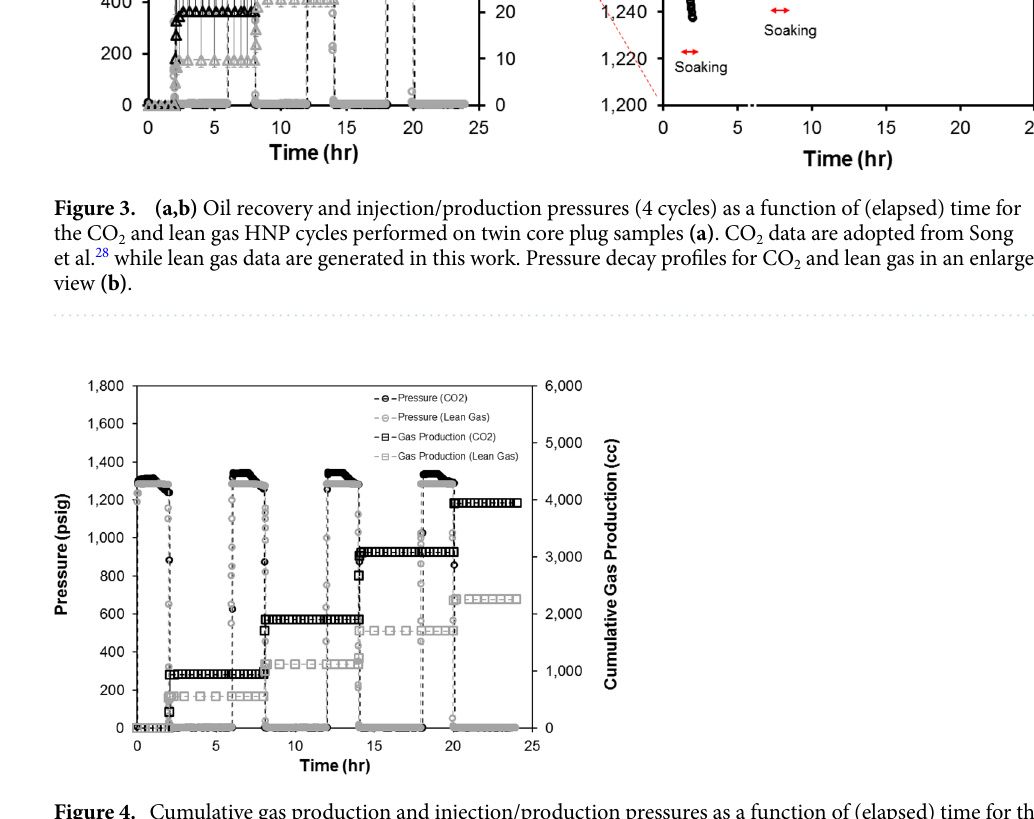
Figure 4. Cumulative gas production and injection/production pressures as a function of (elapsed) time for the CO 2 and lean gas HNP cycles performed on the twin core plug samples (4 cycles). CO 2 data are adopted from Song et al. 28 while lean gas data are generated in this